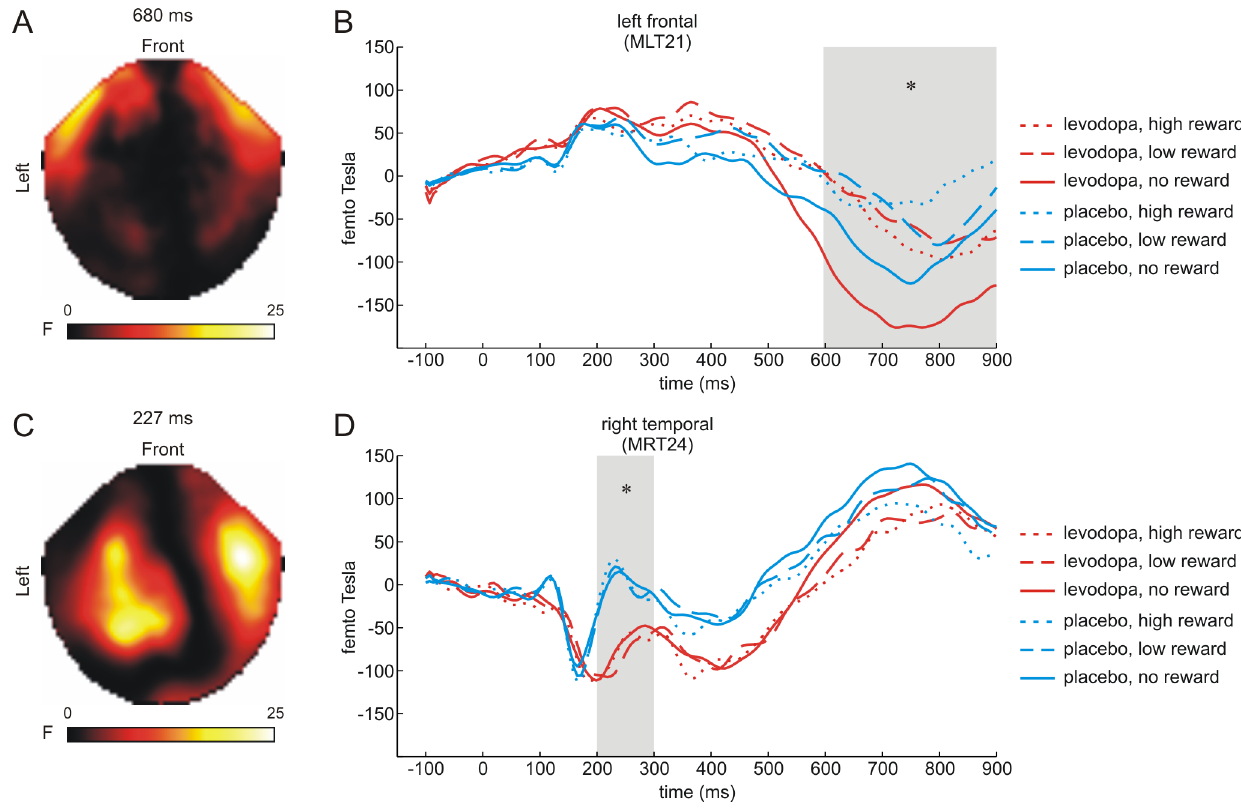
Figure 3. ERFs for reward outcome. SPM-based analyses across all sensors and time-points revealed a main effect of outcome magnitude (high/ 1.00 J , low/0.30 J , no/0.00 J reward outcome) at left temporal sensors (peak at 680 ms; nearest sensor: MLT21) (A). Furthermore, main effects of drug group (levodopa, placebo) arose at right temporal sensors (peak at 227 ms; nearest sensor: MRT24) (C). The main effect of outcome magnitude was driven by more negative deflections for the ‘‘no reward’’ condition compared to both the ‘‘low reward’’ and ‘‘high reward’’ condition in the time window of 600 to 900 ms after stimulus onset (B). The main effect of drug group was due to more negative deflections in the levodopa group compared to the placebo group between 200 and 300 ms (D). Asterisks indicate statistical significant main effects ( p , 0.05).